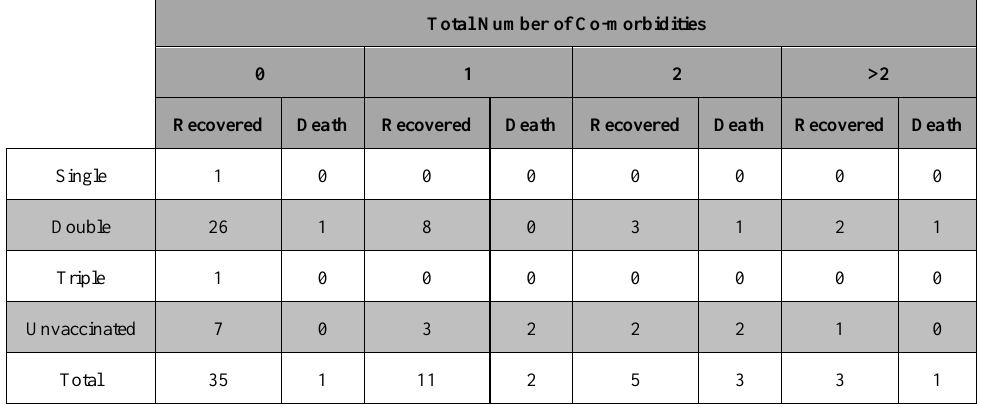
Table 10. A total number of co-morbidities with respect to clinical outcome and vaccination